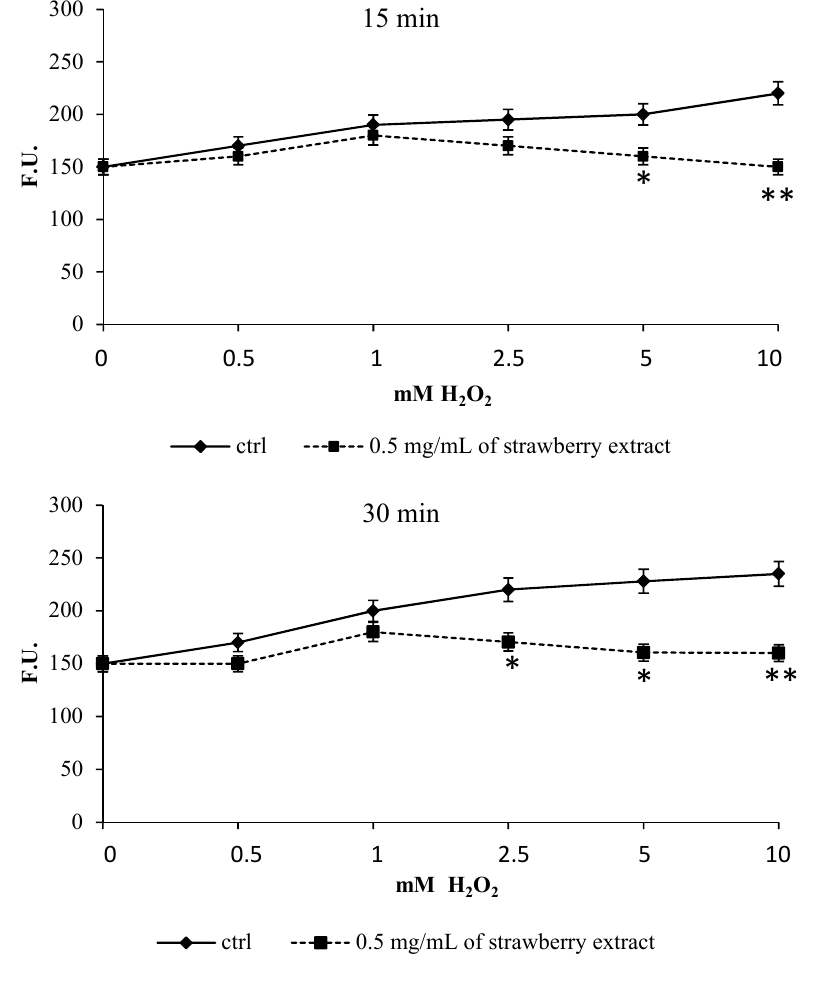
O -induced stress. Control and strawberry 2 2